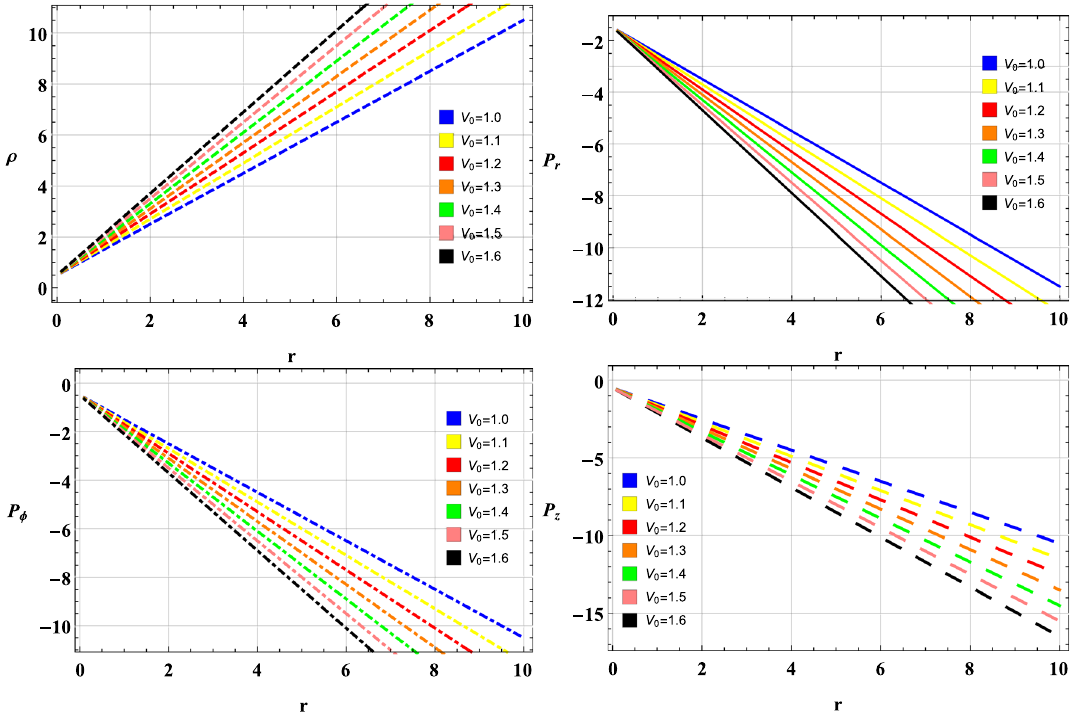
Fig. 21 The first graph show the graphical behavior of energy density (MeV/fm 3 ) which is positive and increasing w.r.t radial coordinate. Whereas, the graphical behavior of P r (MeV/fm 3 ) , P φ (MeV/fm 3 ) and P z (MeV/fm 3 ) is negative and decreasing w.r.t radial coordinate. CASE (F)